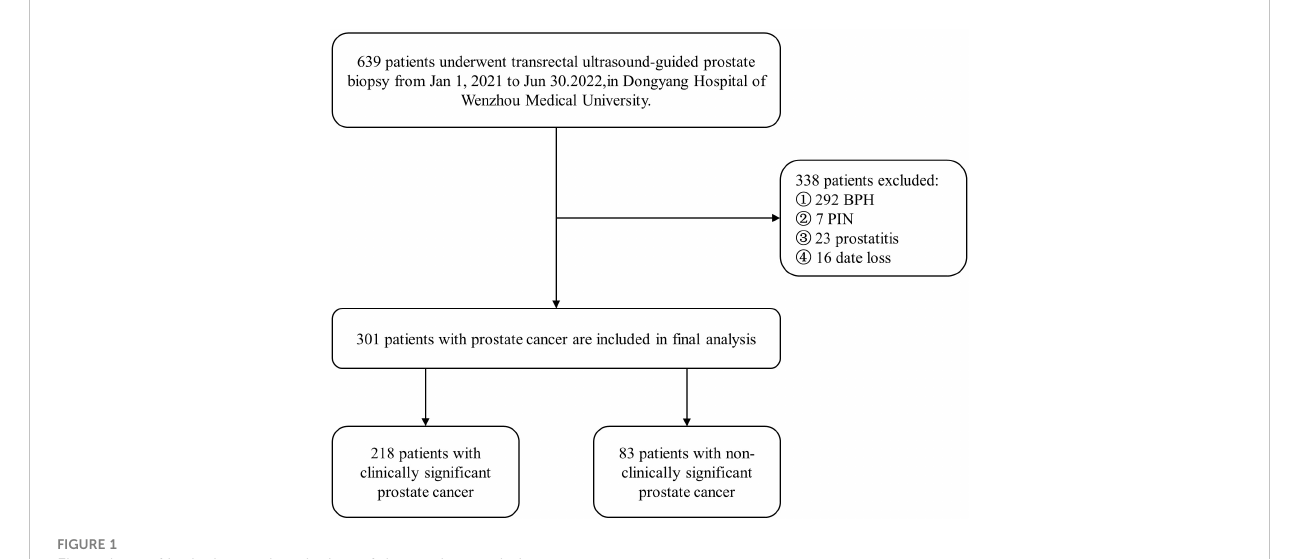
FIGURE 1 Flow chart of inclusion and exclusion of the study